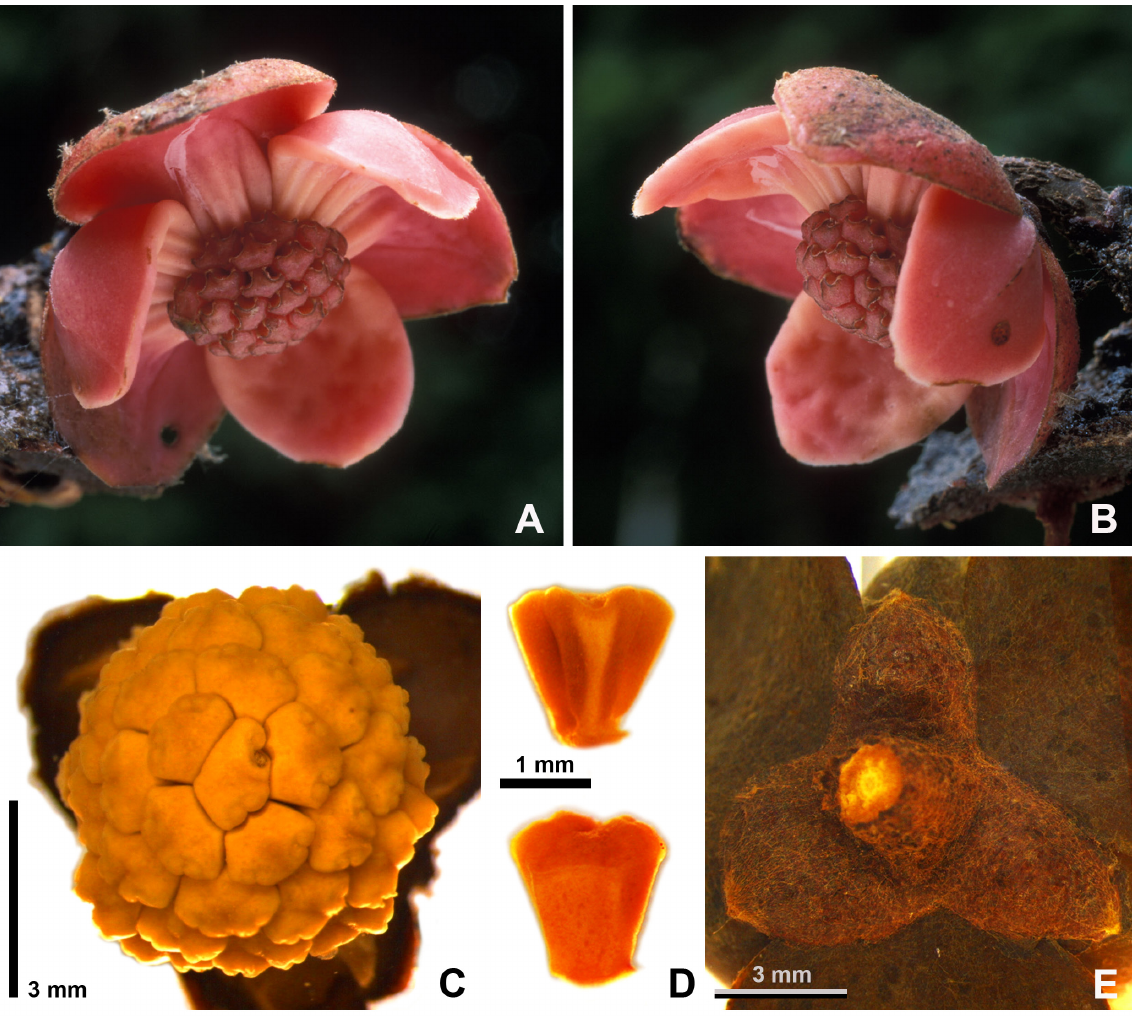
Fig. 4. Flowers and floral organs of Winitia thailandana Chaowasku & Aongyong sp. nov. A–B . Flower. C . Flower with petals removed. D . Stamen, abaxial (above) and adaxial (below) sides. E . Back side of flower, showing sepals (abaxial side). A, B from Gardner & Sidisunthorn ST0817 (L), photographs by S. Gardner; C–E from Aongyong 9